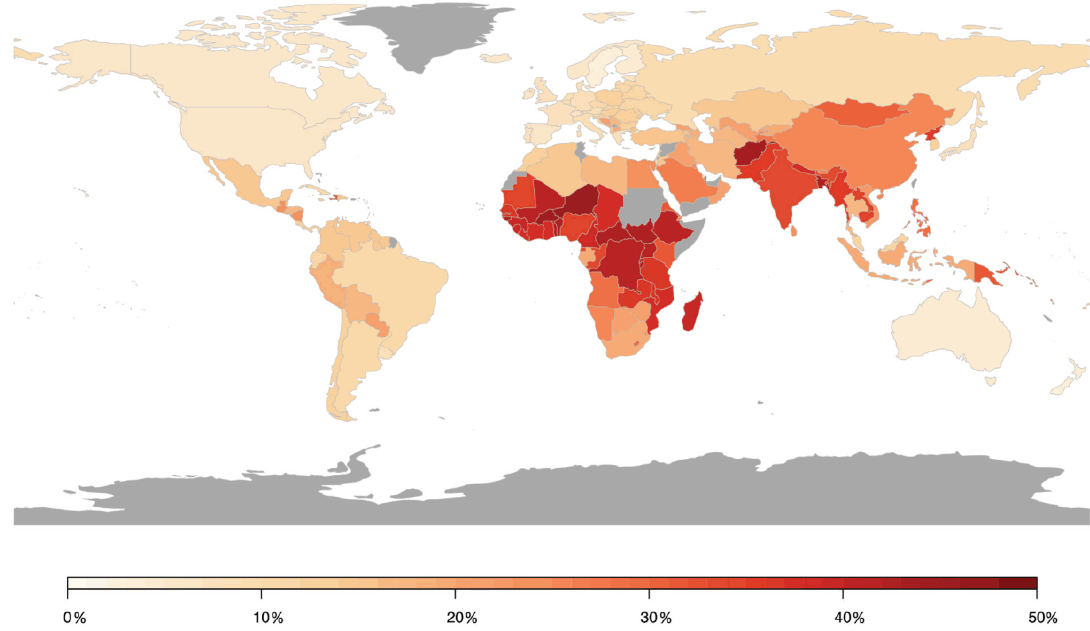
Figure 4. Population attributable risk of cerebrovascular disease associated with air pollution worldwide. Estimates from Institute for Health Metrics and Evaluation (IHME). Reused from Lee et al. [55]